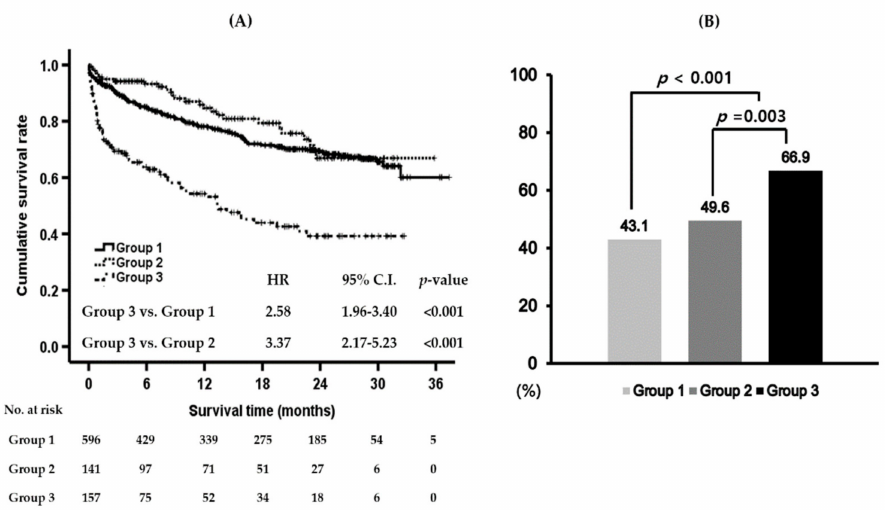
Figure 2. Long-term prognosis of alcoholic liver cirrhosis (LC) patients who were admitted with